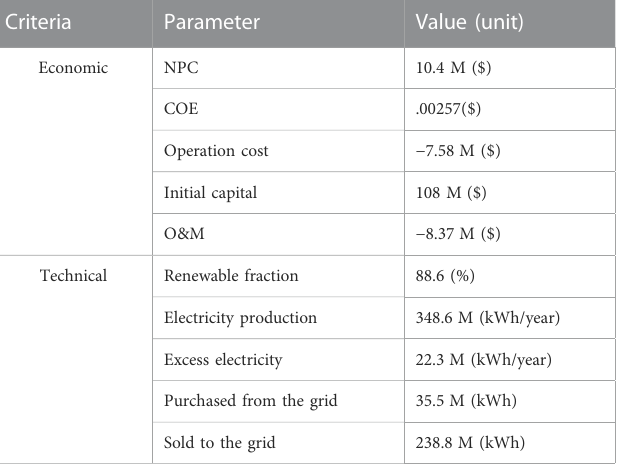
TABLE 2 Results of the optimal 179.168-MW PV on-grid system.